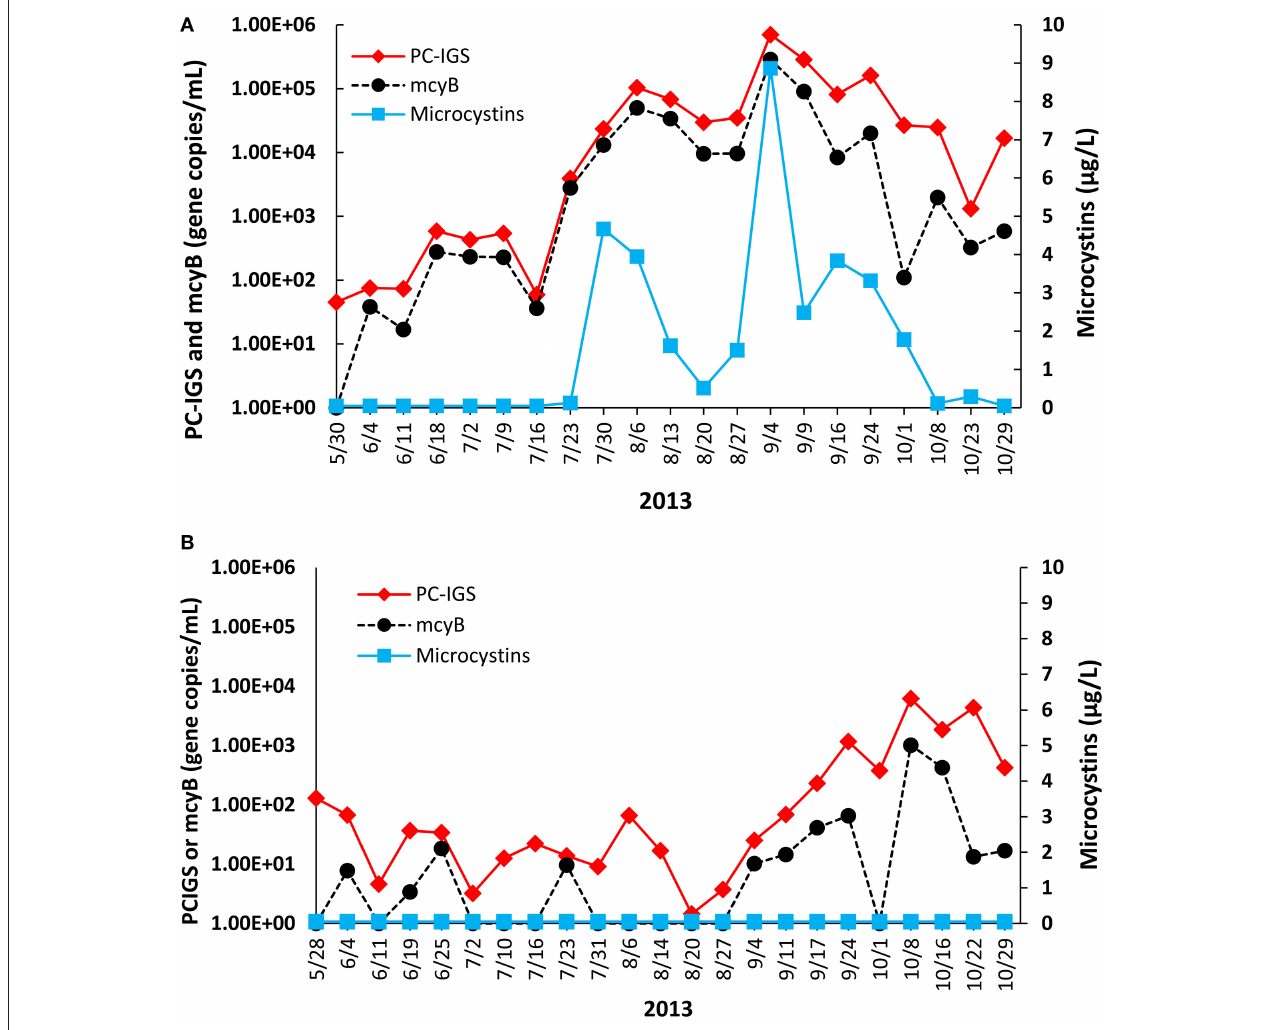
FIGURE 2 | Temporal trends of PC-IGS, mcy B, and microcystins at (A) Toledo and (B) Painesville water plant intake points from May to October in 2013.